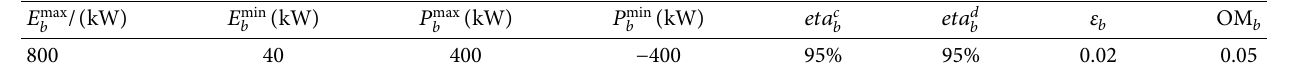
Table 2: Parameter settings of the ESS.